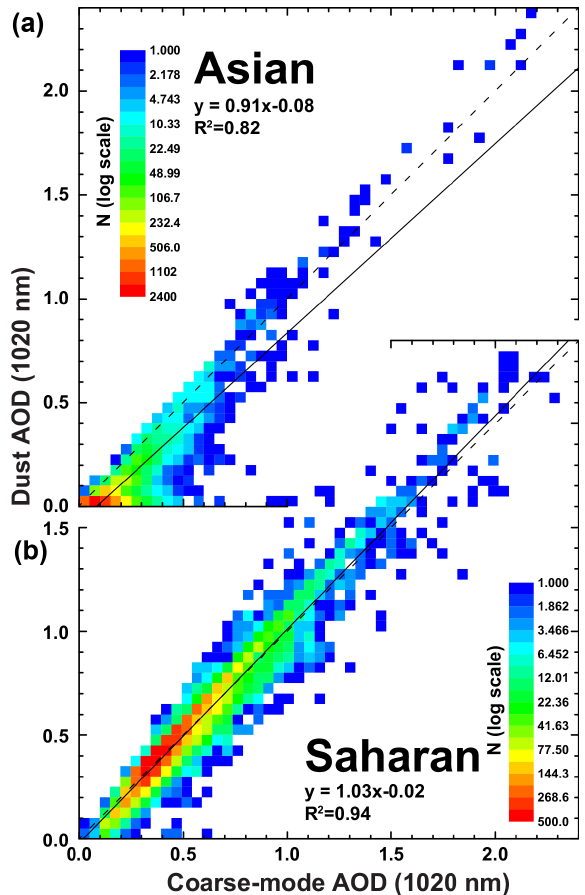
Figure 6. Two-dimensional histograms of 1020nm coarse-mode AOD and dust-related 1020nm AOD for the considered AERONET stations affected by Asian (a) and Saharan dust (b)